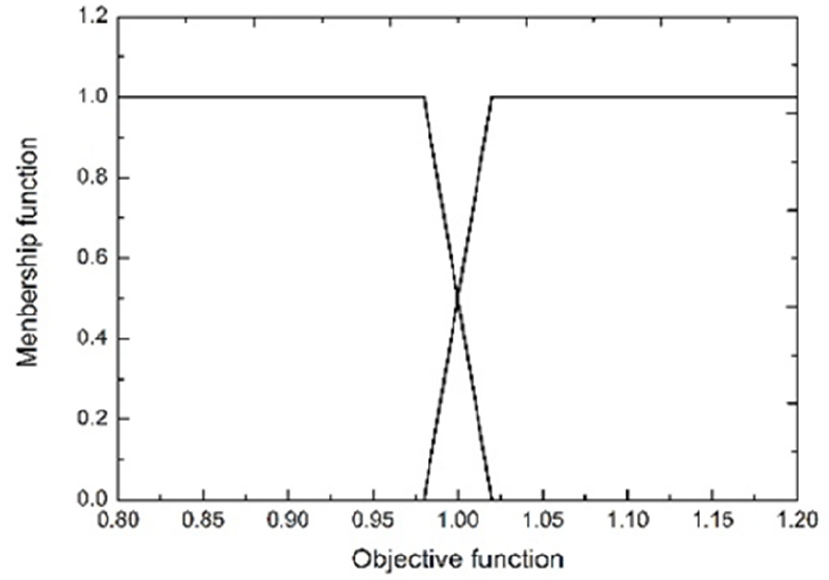
Figure 10. Membership function. The gear shifting area is divided by two lines ( R = 0.98 and R = 1.02 ). The area below the solid line is no gear shifting and above the dotted line is the shifting gear area. More- over, between the solid line and the dotted line is the fuzzy control area, as shown in Figure 11. Figure 11. Gear shifting area division. 4. Optimization Results Analysis The optimization results are shown in Figure 12. Figure 12. Gear shifting schedule in different gears (5 to 4).